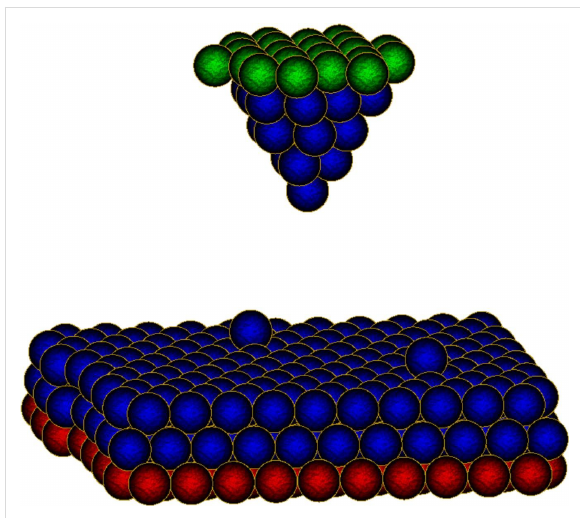
Figure 3: Snapshot of the molecular dynamics simulation showing the different atom types. ‘Normal’ gold atoms are drawn in blue, ‘tip bound- ary’ atoms in green and ‘surface boundary’ atoms in